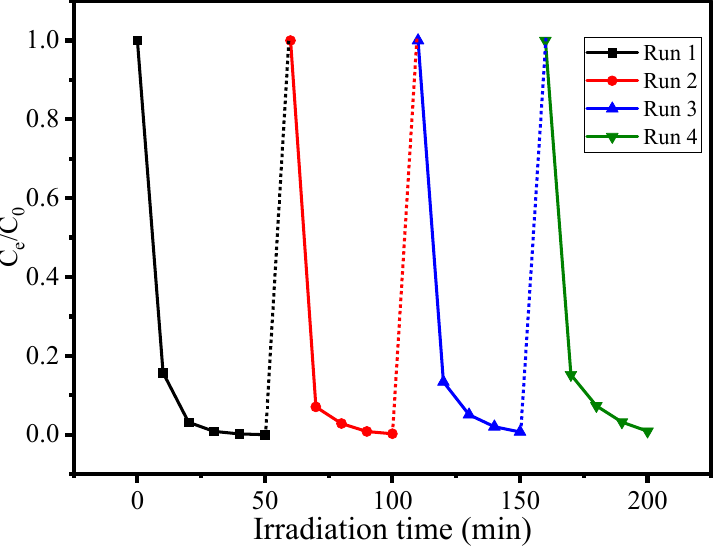
Figure 11. Reusability test for CuO/Alg-Agar BNC towards AN dye using 25 mL aliquot part of 80 mg L –1 at 4 pH with 20 mg of CuO/Alg–Agar BNC for 45 min in presence of visible radiation.